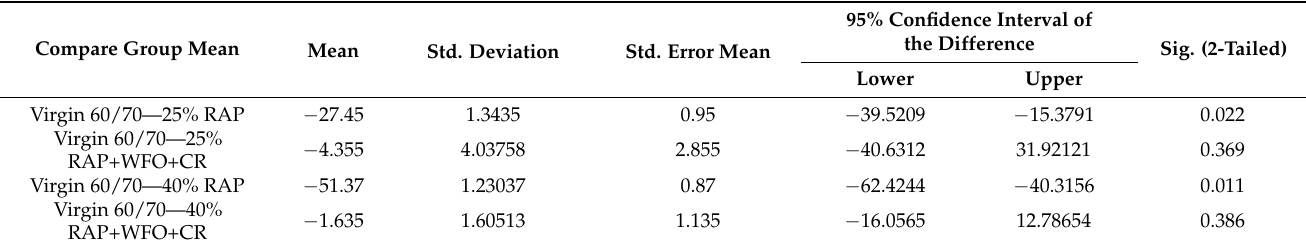
Table 12. Comparison of significant difference of group means for the G* result at different